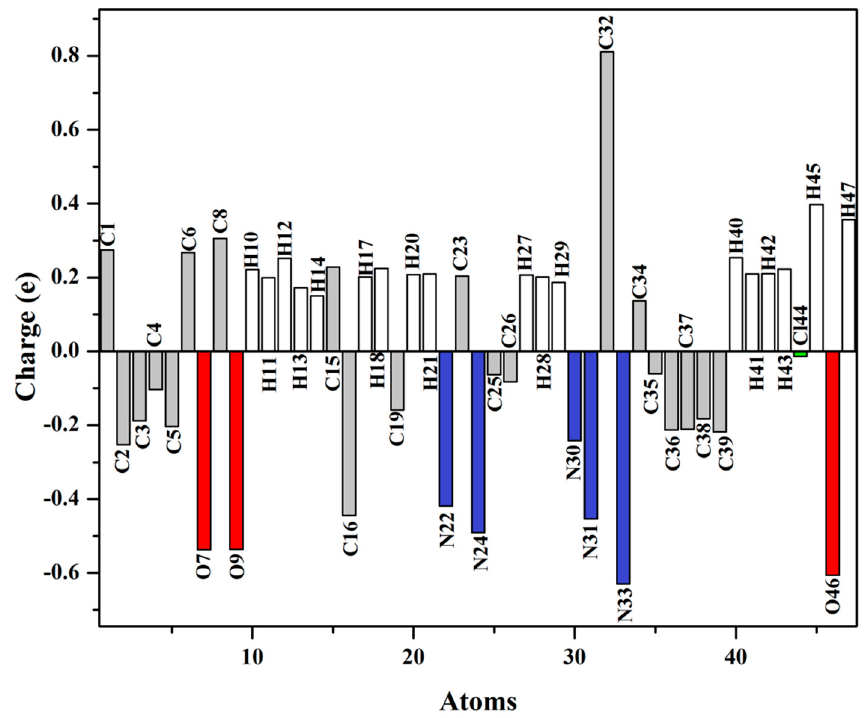
Figure 4. Charge distribution on the atoms of the semicarbazone 4 .